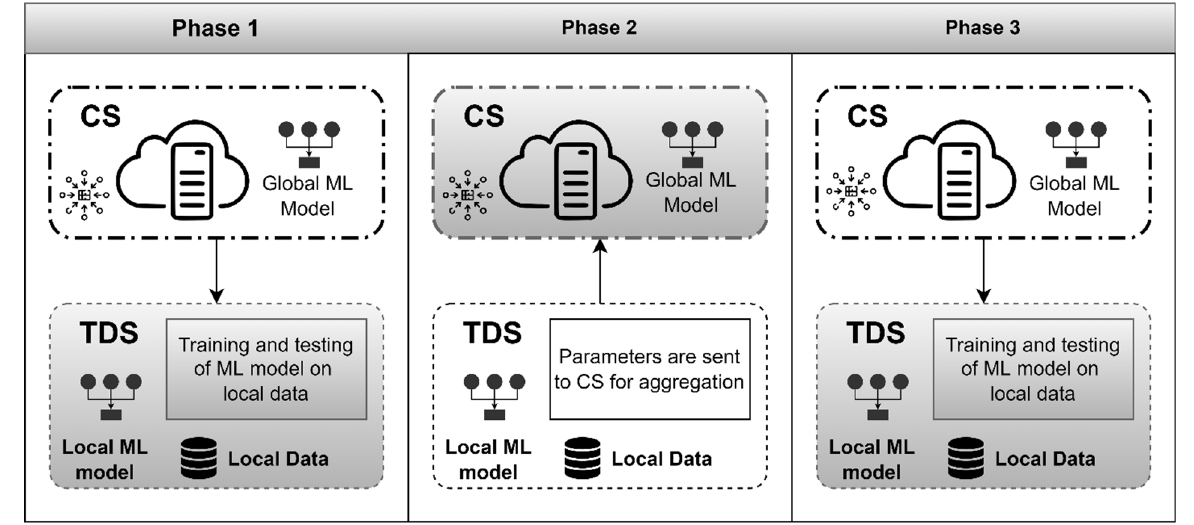
Figure 3. An illustration of the FedDP architecture. The shaded area represents the working in the specific phase.